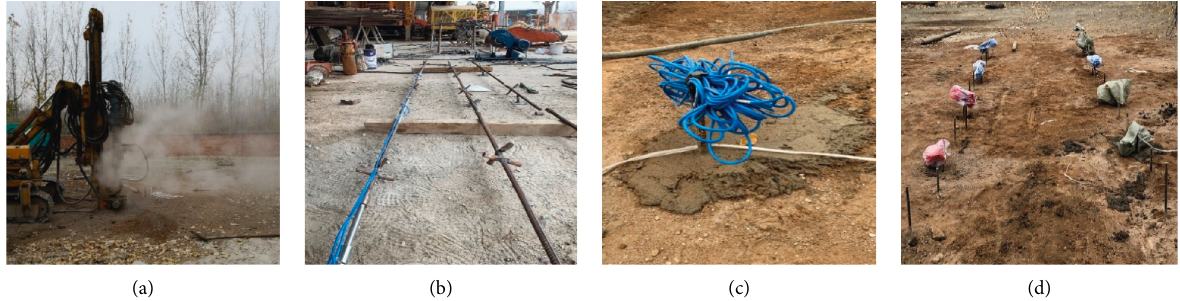
Figure 3: Construction of pile. (a) Drilling hole. (b) Assembly process of main reinforcement. (c) Grouting of retaining pile. (d) Completion of pile construction.